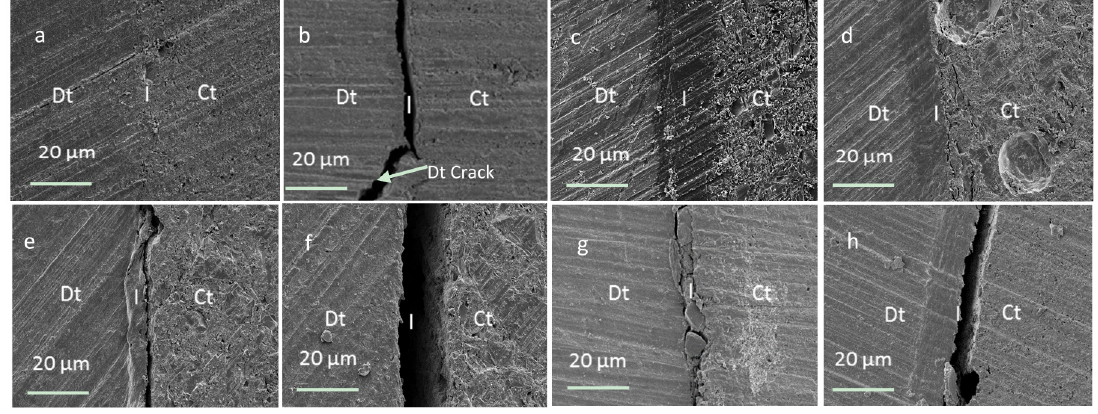
Figure 5. SEM images of interfaces between composites and dentine ( a ) ibond treated dentine with 4-META composite shows 3 different zones (dentine (Dt), interface (I), & composite (Ct)); ( b ) with ibond treated dentine and Z250 some interface and dentine cracking is observed; ( c ) acid and ibond treated dentine with 4-META composite has an ~20 micron thick interface layer; ( d ) Acid etched dentine with 4-META composite shows only minor cracking within the composite; ( e ) Un-treated dentine with 4-META composite has gaps of <2 micron whilst ( f ) un-treated dentine with HEMA composite has gaps >10 micron; ( g ) ibond treated dentine and Z250, failure at dentine interface can be seen; ( h ) Is acid and ibond treated dentine and Z250, the failure can be seen at dentine-ibond